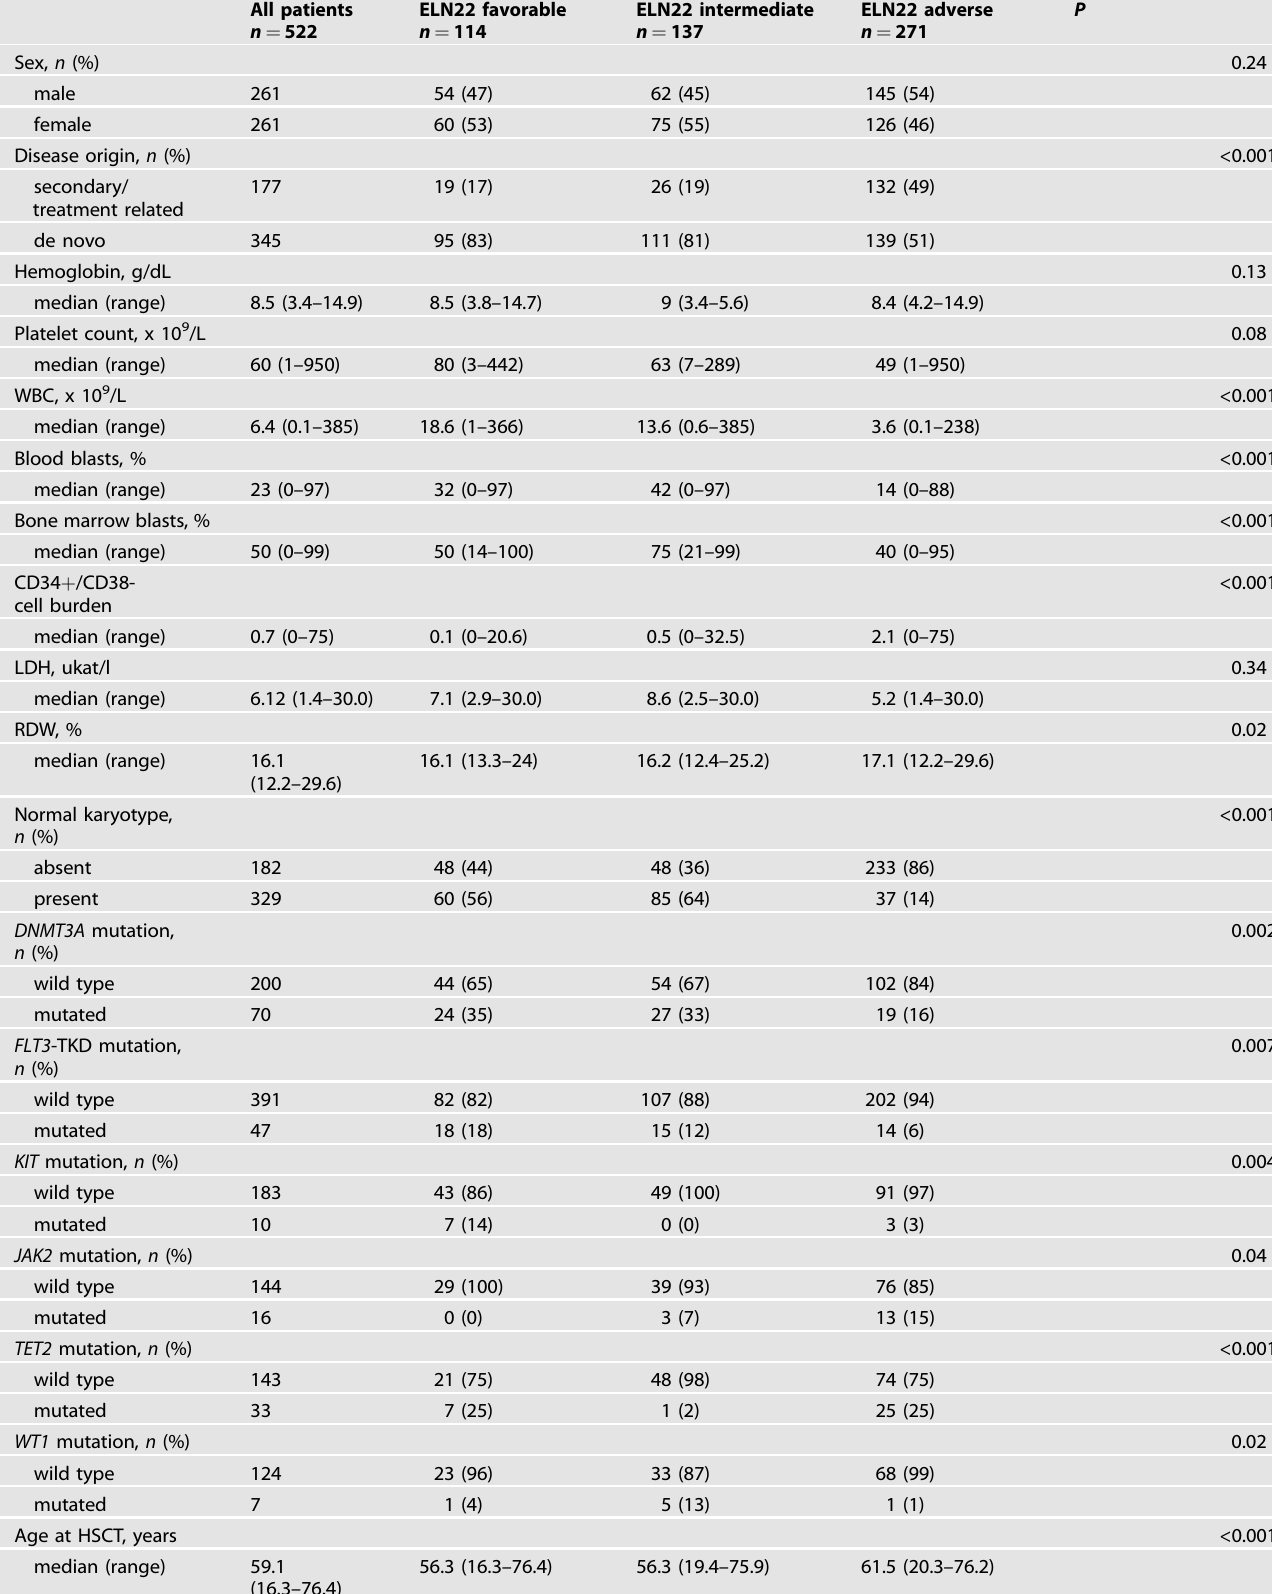
Table 1. Patients ’ characteristics according to the ELN2022 genetic risk at diagnosis ( n =